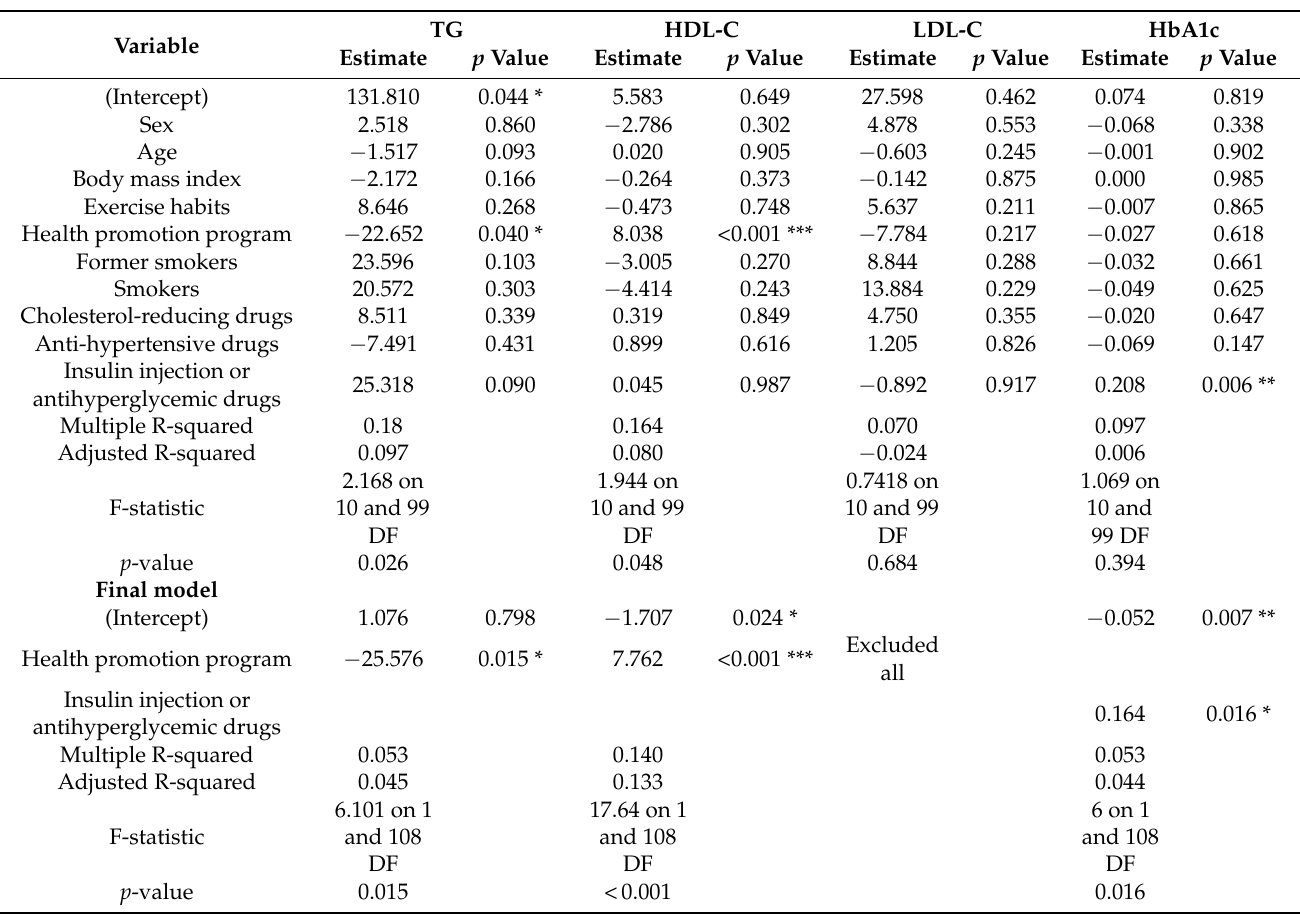
Table 4. Influential factors of